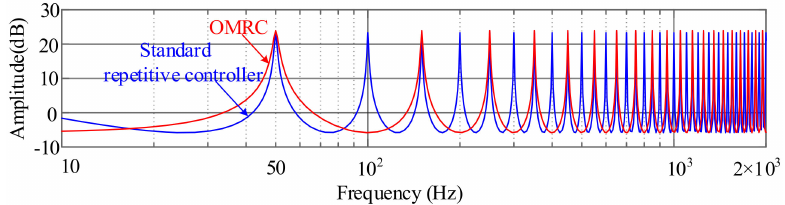
Figure 9. Bode diagram of